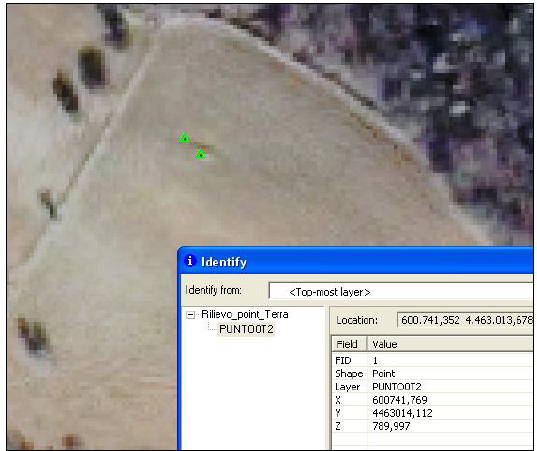
Figure 9. Error in positioning of GCP (test 1)